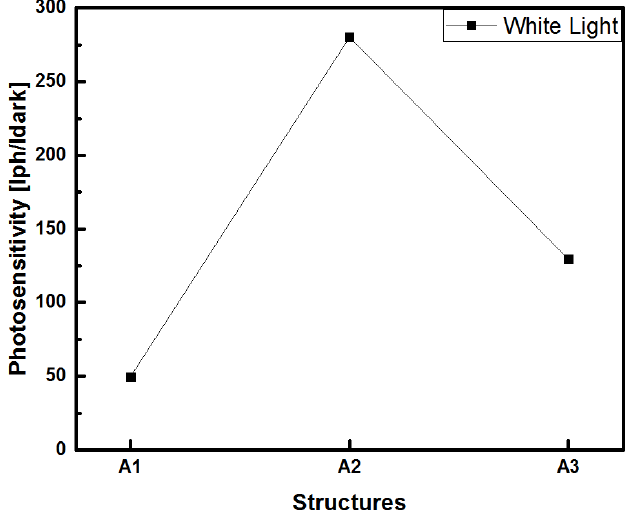
Figure 12. Photosensitivity of Au/SRO/Si structures at − 4 V for the case of the unannealed A1, A2, and A3 SRO films.